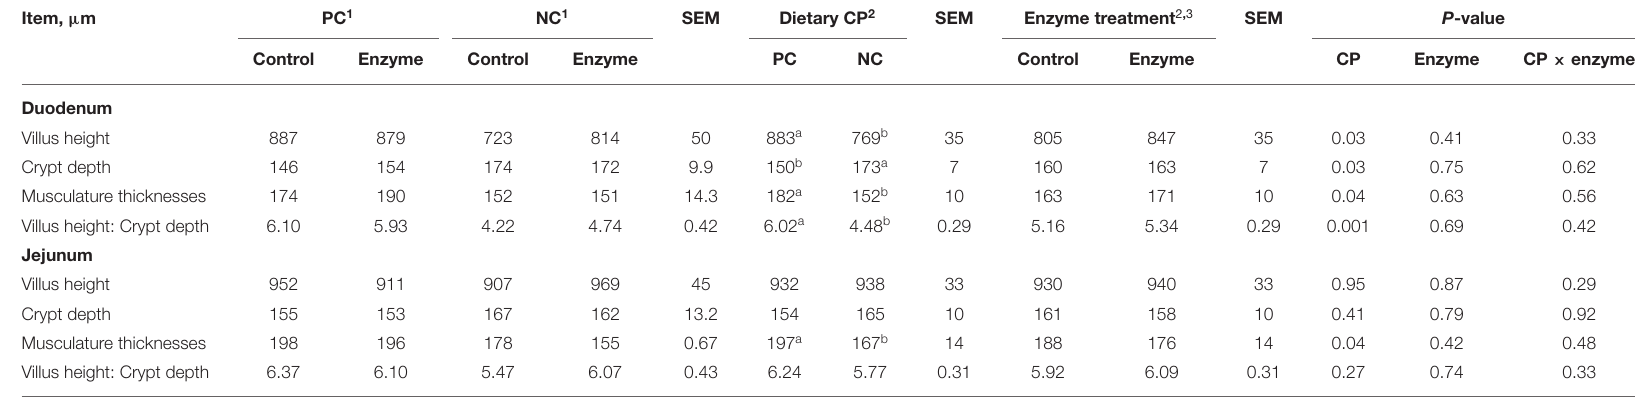
TABLE 5 | Effects of NSP enzymes and protease on intestinal histomorphology of yellow-feathered broilers fed with diets with different CP levels on day 56. Item, µ